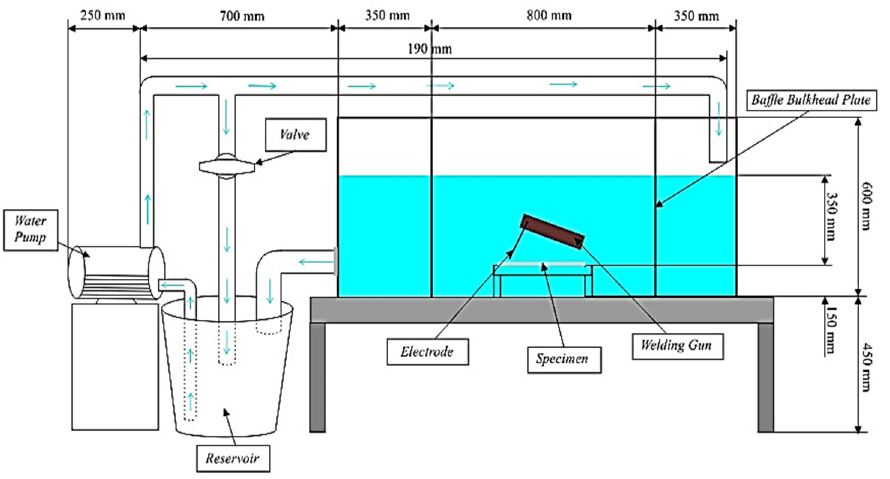
Figure 4. Dimensions of the water flow simulation glass box.